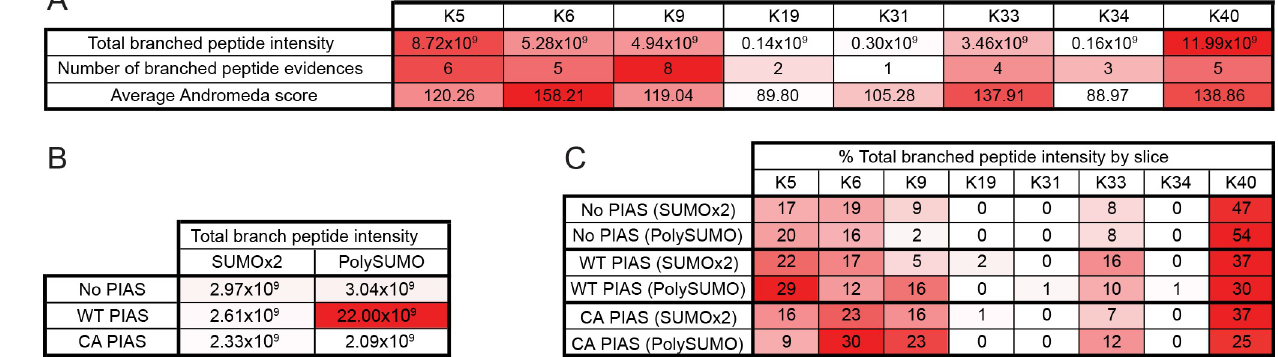
Fig 3. Internal lysine acceptor residues for Aa SUMO modification. (A) Summary of mass spectrometry data (S2 Fig) associated with branched SUMO peptides identified on SUMO Lys (K5, K6, K9, K19, K31, K33, K34, and K40) acceptor residues from in vitro reaction mixtures containing Aa SAE1/2, Aa Ubc9, and Aa SUMO. Data aggregated from all samples. MaxQuant Andromeda (peptide assignment score) values shown. (B) Total branched peptide intensity for all Lys acceptor residues from in vitro reaction mixtures (as in A) incubated in the presence or absence of WT or catalytically inactive (C371A, CA) Aa PIAS (as shown). (C) Slice-specific (dimeric SUMO, SUMOx2; HWM SUMO conjugates, polySUMO) peptide intensity data of Lys-specific acceptor residues. Data presented as a percentage of the total intensity of all branched peptides found in each gel slice. Representative spectra can be found in S7–S14 Figs. Data summary presented in S2 File. N =